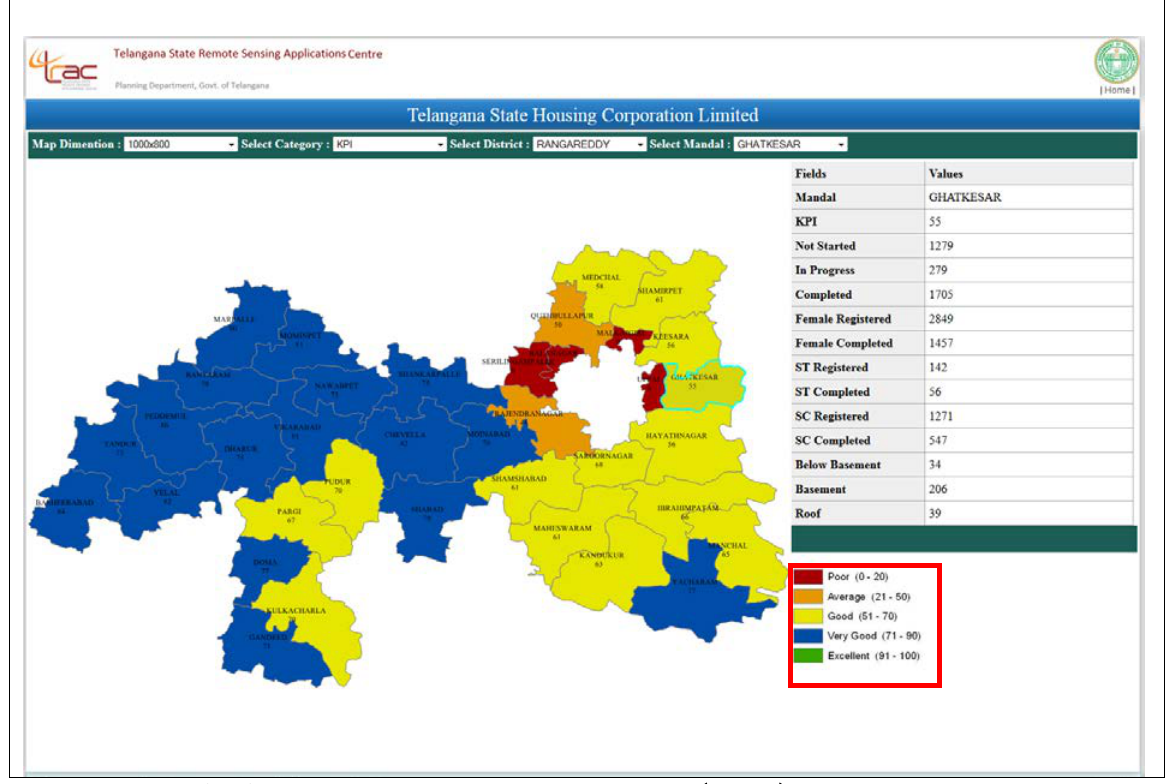
Figure 2: Web interface for Telangana State Housing Corporation Limited (TSHCL)